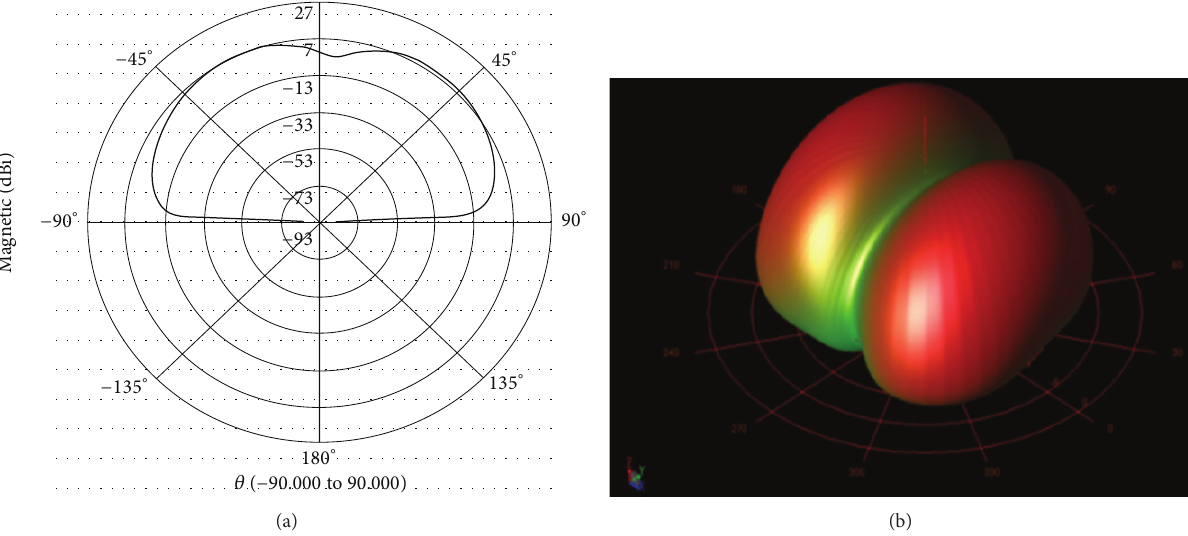
Figure 10: Simulated radiation gain patterns of the second proposed antenna composed of six unit cells in elevation plane (Φ = 0 ∘ ) and at operation frequency 𝑓 = 16 GHz. (a) Two-dimensional (2D) case, (b) three-dimensional (3D)